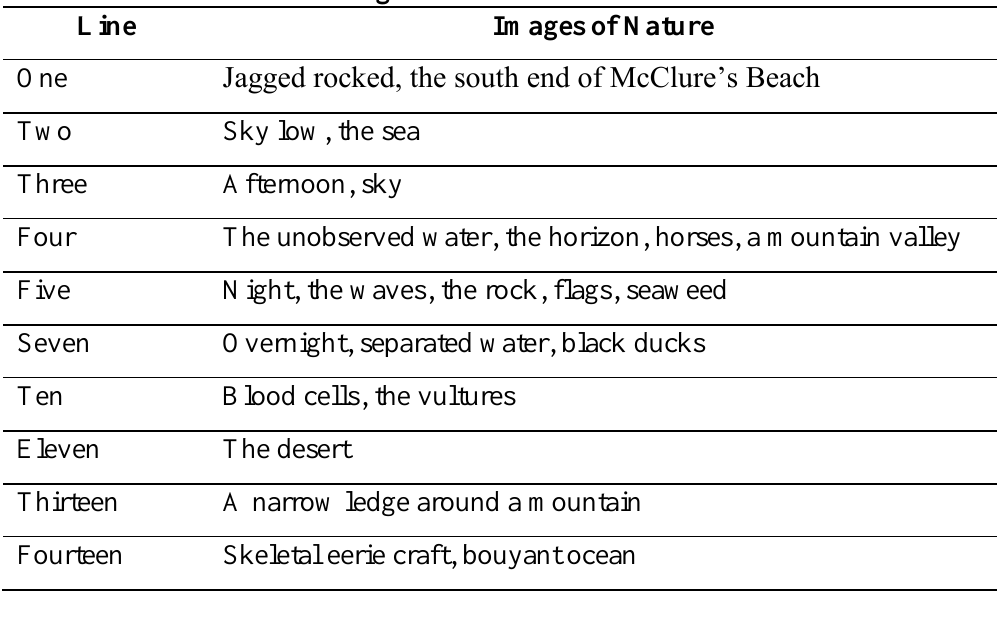
Table 1. Images of Nature in Each Line